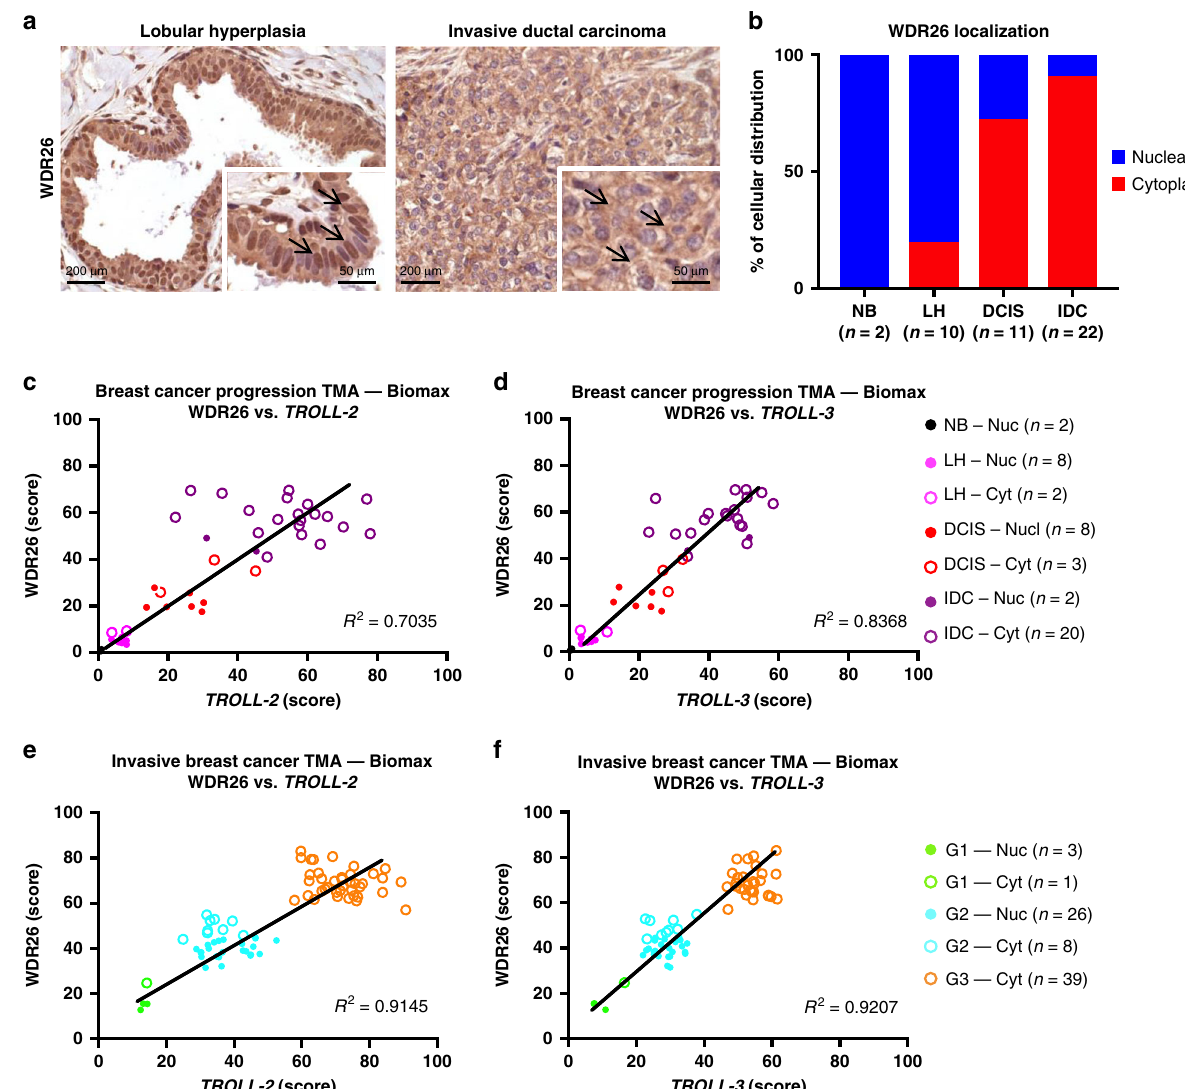
Fig. 4 WDR26 localization correlates with breast cancer progression. a Representative IHC images for WDR26 in lobular hyperplasia (left) and invasive ductal carcinoma (right). b Quanti fi cation of the percentage of WDR26 cellular distribution in the TMA of breast cancer progression shown in Fig. 2a. c – f Correlation of the IHC score and cellular distribution of WDR26 with the ISH score of TROLL-2 and TROLL-3 in the indicated TMAs based on tissue type ( c , d ) or tumour grade ( e , f ). Source data are provided as Source data fi